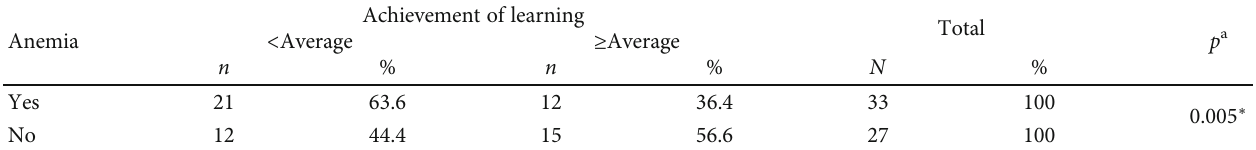
Table 6: Anemia and achievement of